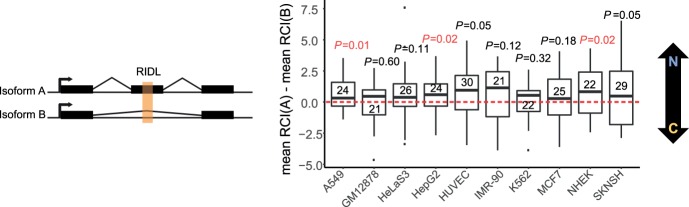
RIDLs correlate with differential localization of lncRNA transcripts from the same locus. Distribution of differences between RCI mean of transcripts with nuclear RIDL (mean RCI(A)) and RCI mean of transcripts without nuclear RIDL (mean RCI(B)). A positive value indicates that RIDL-carrying transcripts are more nuclear-enriched than non-RIDL transcripts. Data were calculated individually for every gene that has one or more RIDL-transcript and one or more non-RIDL transcript expressed in a given cell line. Numbers inside the boxplots indicate the number of gene loci analyzed for each cell line. Horizontal bar indicates the median. Here nuclear RIDL refers to L1AP16, MIRb, MIRc, and L2b. P-values obtained from one-sided t-test are shown (in red when P < 0.05).